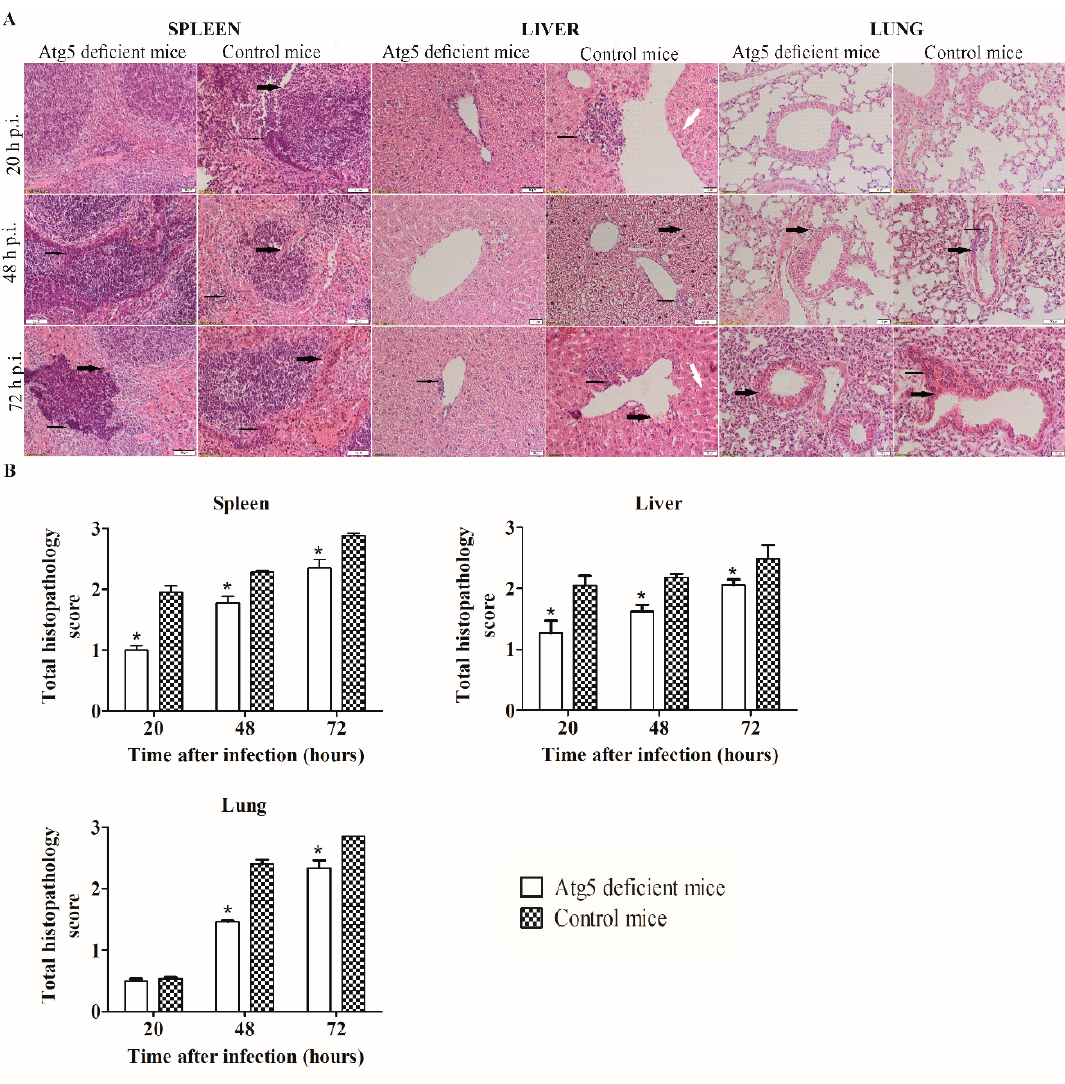
Figure 3. Histopathology and histopathology scoring of spleen, liver and lung tissue. At 20, 48, and 72 h after intradermal infection of the Atg5-deficient and control mice with the LVS, spleen, liver, and lung tissue sections were stained with hematoxylin and eosin (H&E). The experiments were conducted in triplicate using three mice per group. ( A ) A thin black arrow shows inflammatory infiltration, a thin white arrow shows the vacuolation of hepatocytes in the liver tissue, and a thick black arrow shows the destruction of the tissue parenchyma. Scale bars either 10 µ m or 50 µ m. ( B ) Twenty random high-powered fields were assessed. The spleen was scored for destruction of architecture of white pulp, red pulp and capsule (0—absent, 1—slight, 2—moderate, 3—severe). Liver was scored for inflammatory infiltrates and hepatocyte vacuolation (0—absent, 1—slight, 2—moderate, 3—severe). Lung tissue was scored for the alveolar and bronchial destruction, and infiltration of mononuclear cells (0—absent, 1—slight, 2—moderate, 3—severe). The error bars represent SD. * p < 0.05 was considered significant in comparison to control mice.